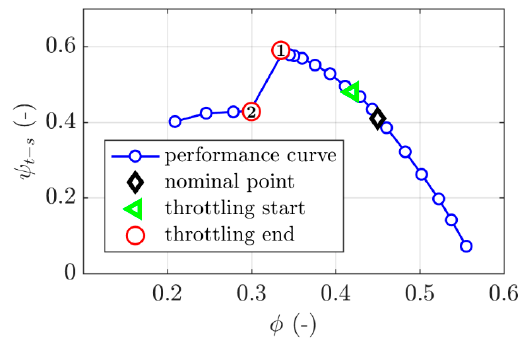
Figure 2. Compressor performances.